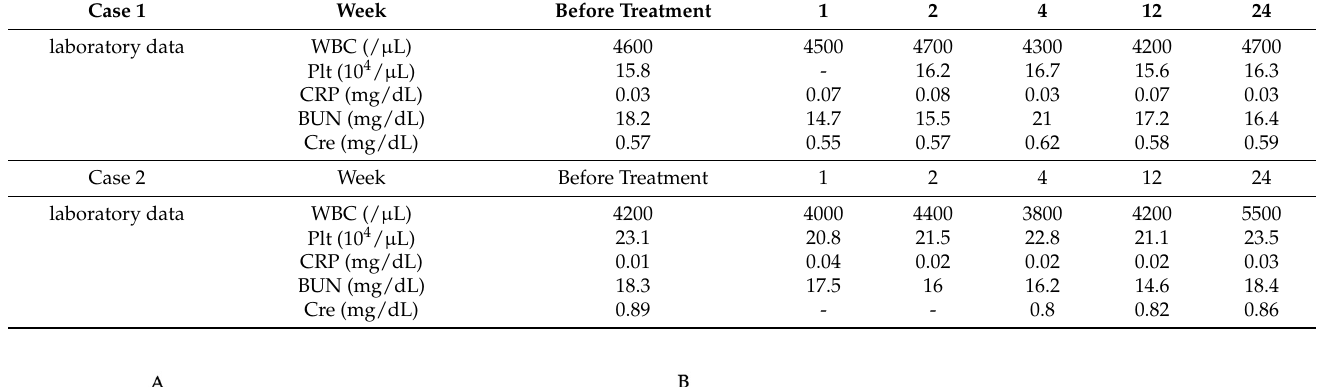
Figure 3. MRI images before PRP administration for case 1 and case 2. ( A , B ) are MRI images before PRP administration for case 1 and case 2, respectively, showing Modic type 1 at L2/3 in case 1 and at L4/5 in case 2 (yellow arrows).